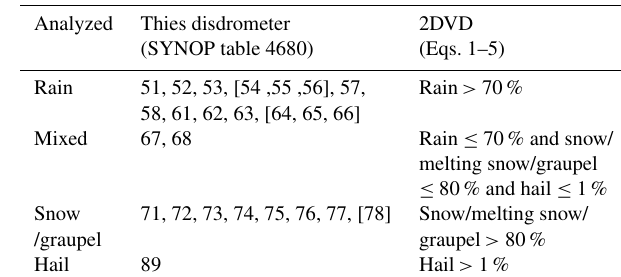
Table 1. Reclassification scheme used for the comparison of domi- nant precipitation phase (1min) between the Thies disdrometer and the two-dimensional video disdrometer (2DVD). Note that codes in square brackets refer to precipitation types that are not yet identifi- able automatically, i.e., that are not reported by the